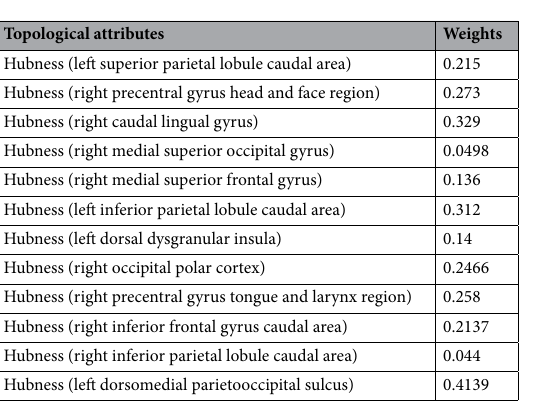
Table 3. The importance of 12 topological attributes values in the classifying process. Hub (i) = weighted hub of node I; Weights = the importance of topological attributes.